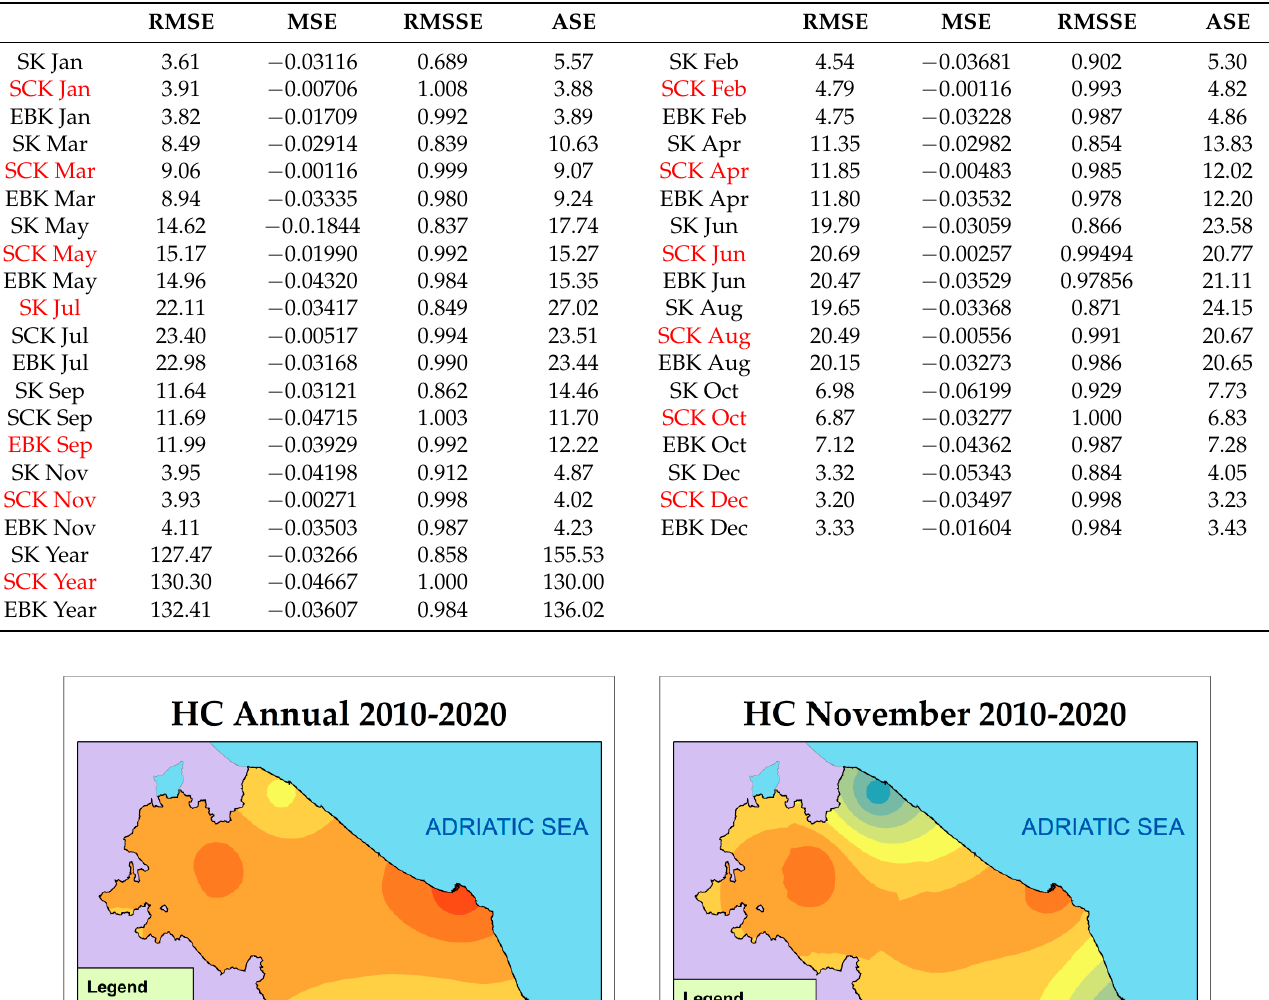
Table 8. Cross validation results for each time interval and for each geostatistical method used; the best method for each interval is highlighted in red.